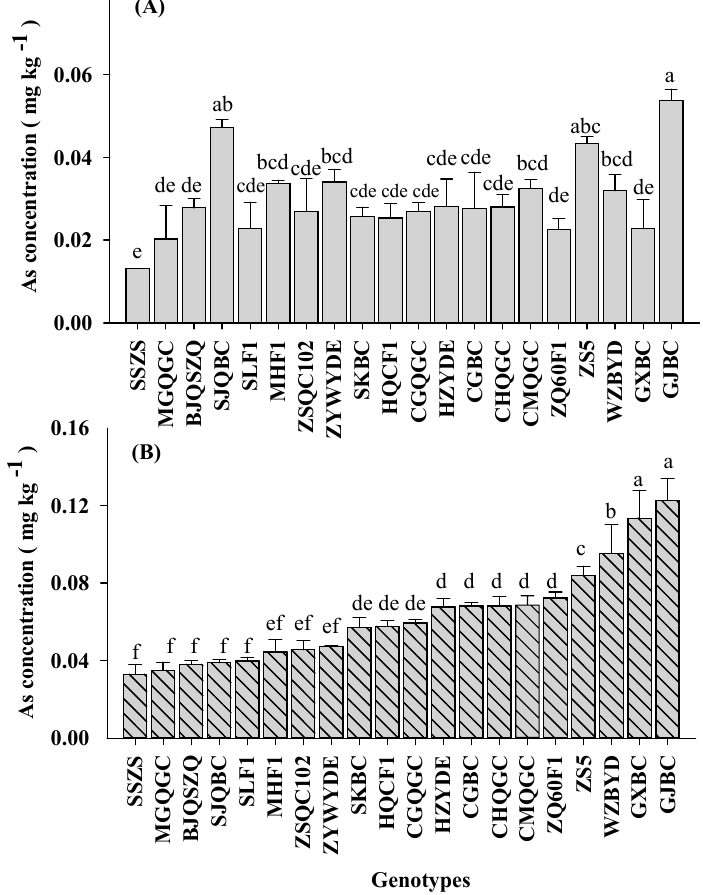
Figure 3. Shoot As concentrations in pakchoi among 20 genotypes grown in low-level co-contaminated soil ( A ) and high-level co-contaminated soil ( B ). Error bars depict standard errors of the means ( n = 3). Different letters depict significant difference among genotypes according to the LSD test ( p < 0.05).